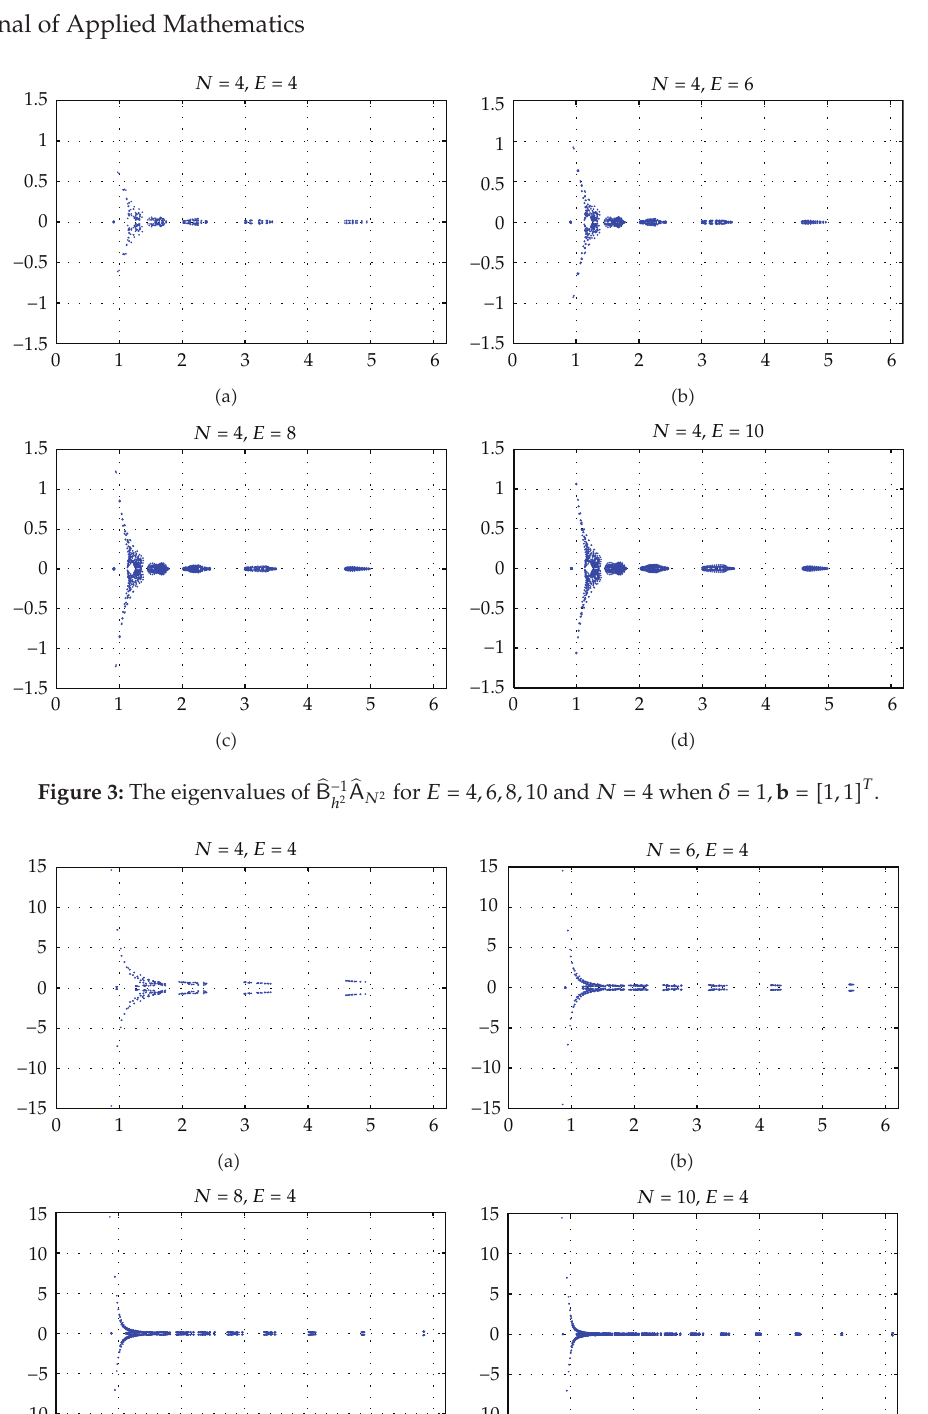
Figure 4: The eigenvalues of